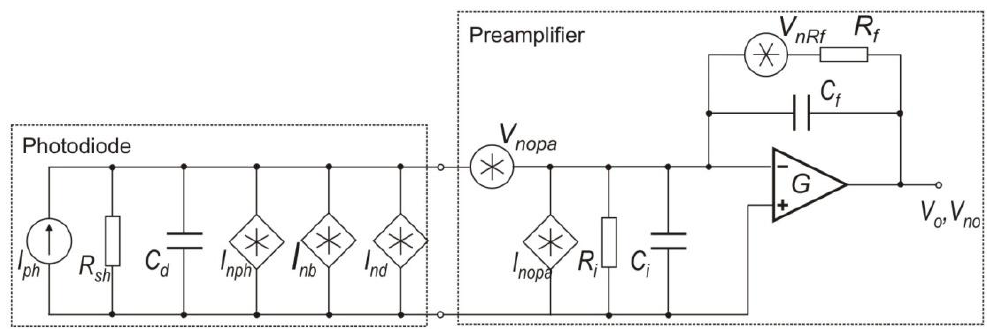
Figure 11. Scheme of the photoreceiver with a